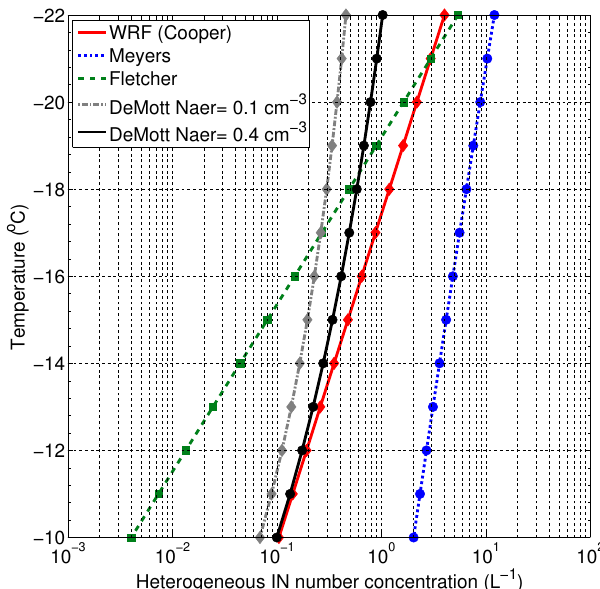
Fig. 10. IN concentrations predicted by various parameterizations as a function of temperature. Two different aerosol concentrations were used in the DeMott scheme as indicated in the legend. For the Meyers scheme water saturation conditions have been assumed to emulate condensation